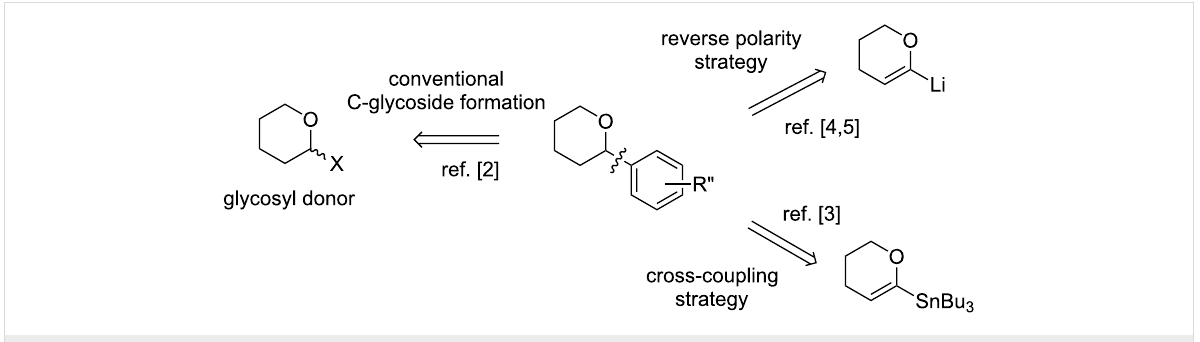
Figure 2: Glycals as relevant scaffolds for constructing aryl C-glycosidic linkage.